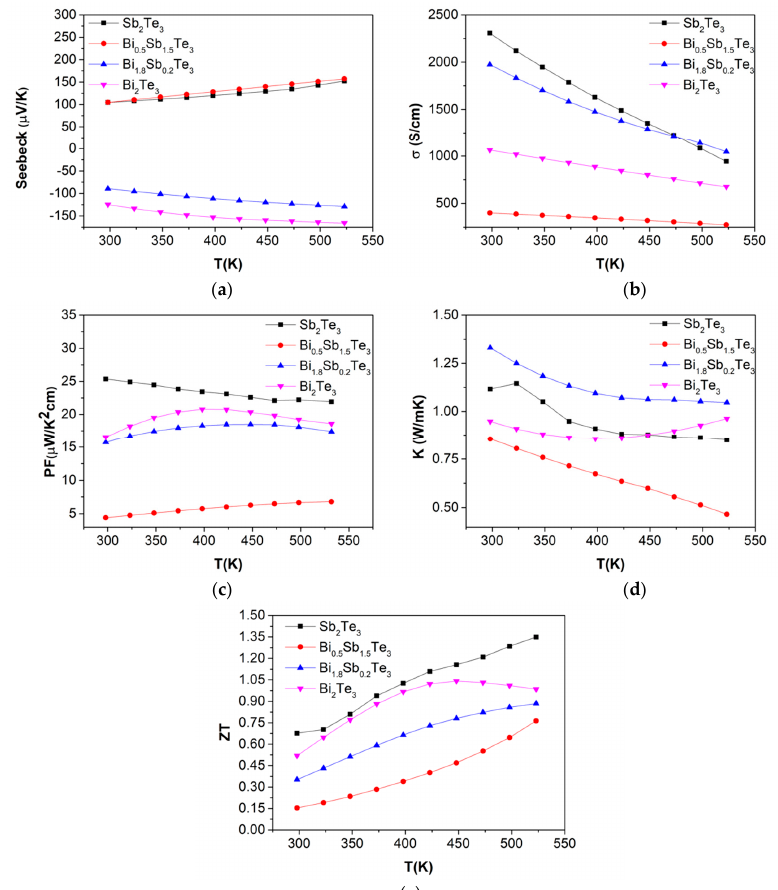
Figure 3. The temperature dependent transport properties of the synthesized Bi 2 − x Sb x Te 3 samples: ( a ) Seebeck coefficient, S ; ( b ) electrical conductivity, σ ; ( c ) Power factor; ( d ) thermal conductivity, κ ; and ( e ) the overall thermoelectric figure of merit, ZT .